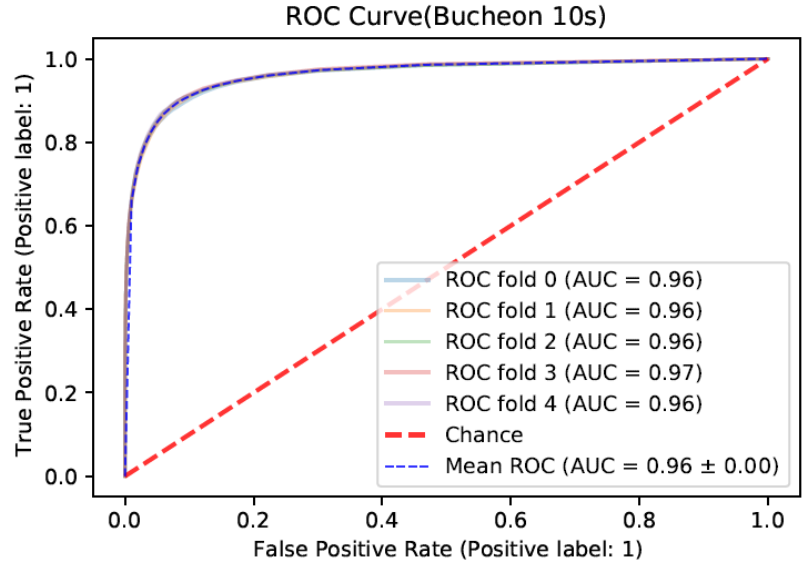
Figure 9. Receiver operating characteristic curves for each fold.